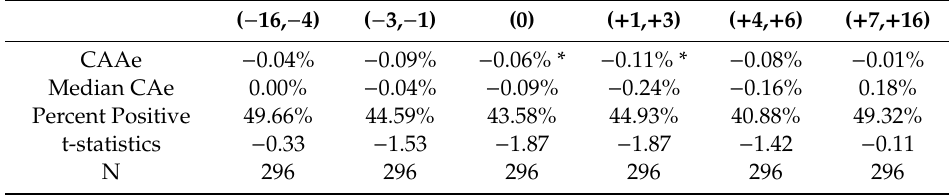
Table 1. The e ff ect of gas discoveries on the real exchange rate for the entire sample of 296 pure announcements. CAAe: cumulative average abnormal exchange rate return, CAe: median cumulative abnormal exchange rate